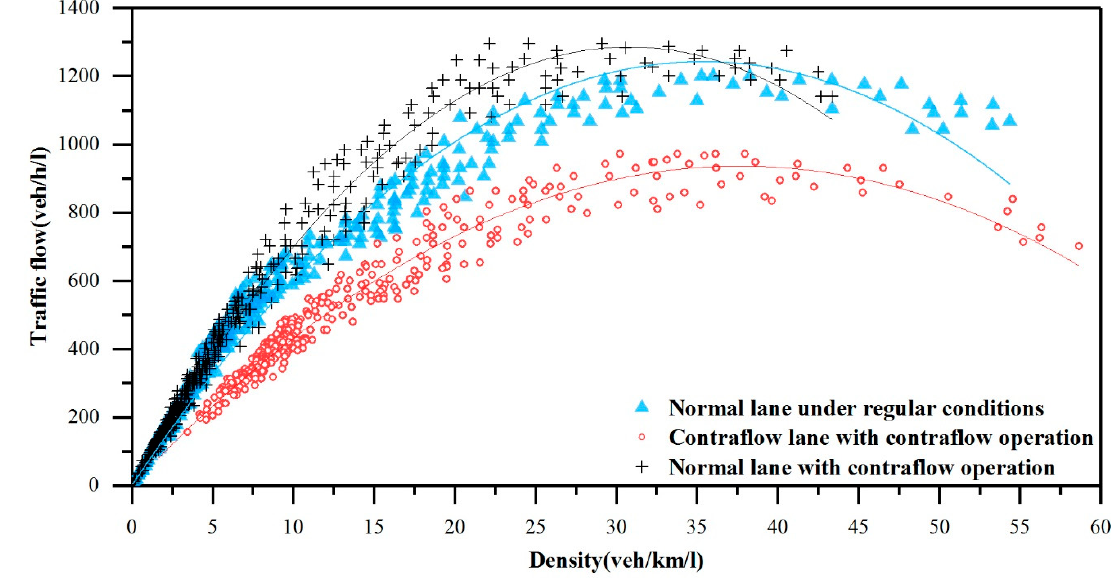
Figure 3. Flow densities with and without the implementation of the contraflow strategy.